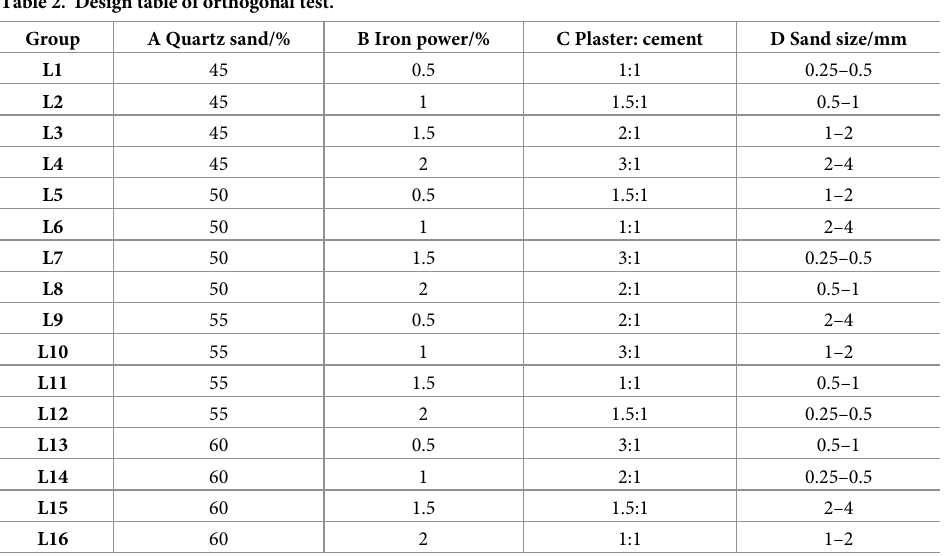
Table 2. Design table of orthogonal test.